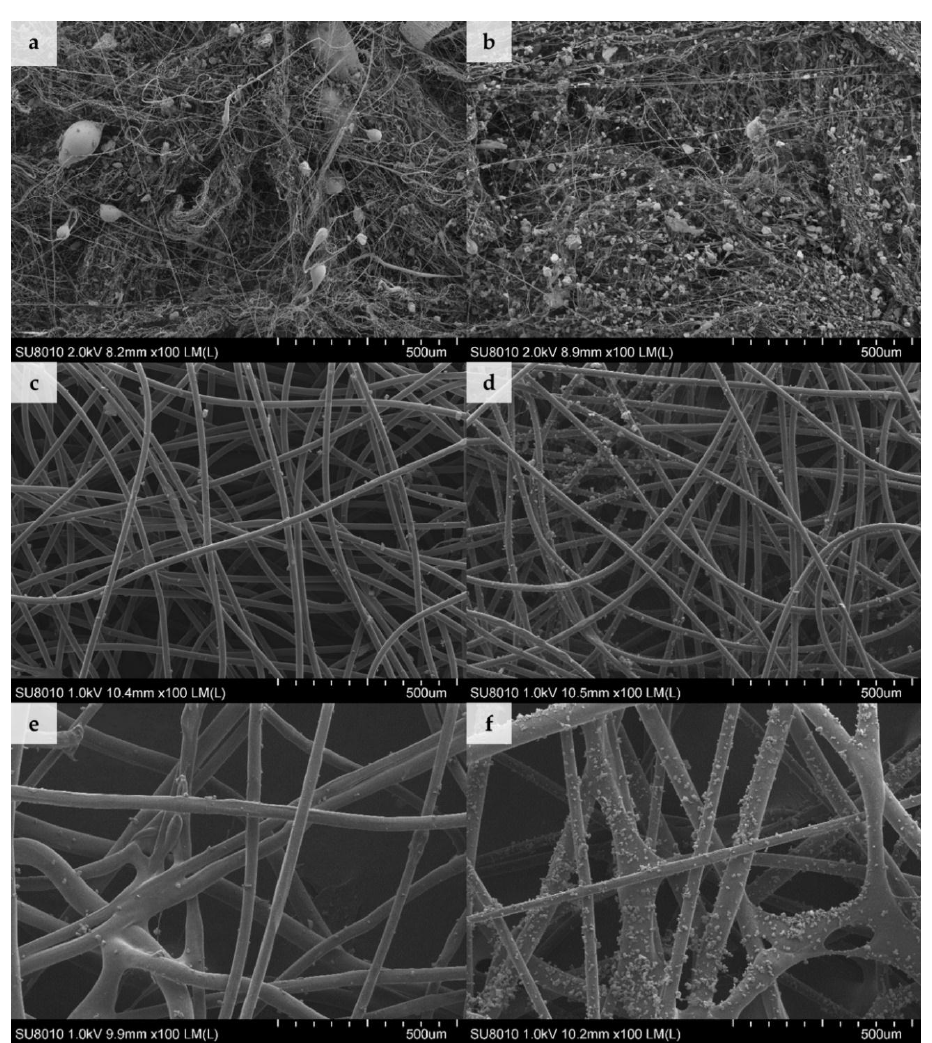
Figure 1. Scanning electron microscopy (SEM) images of nonwovens loaded with dust for 4 min( a ) MB with dust A, ( b ) MB with dust B, ( c ) SB with dust A, ( d ) SB with dust B, ( e ) NP with dust A, and ( f ) NP with dust B (100× magnification).